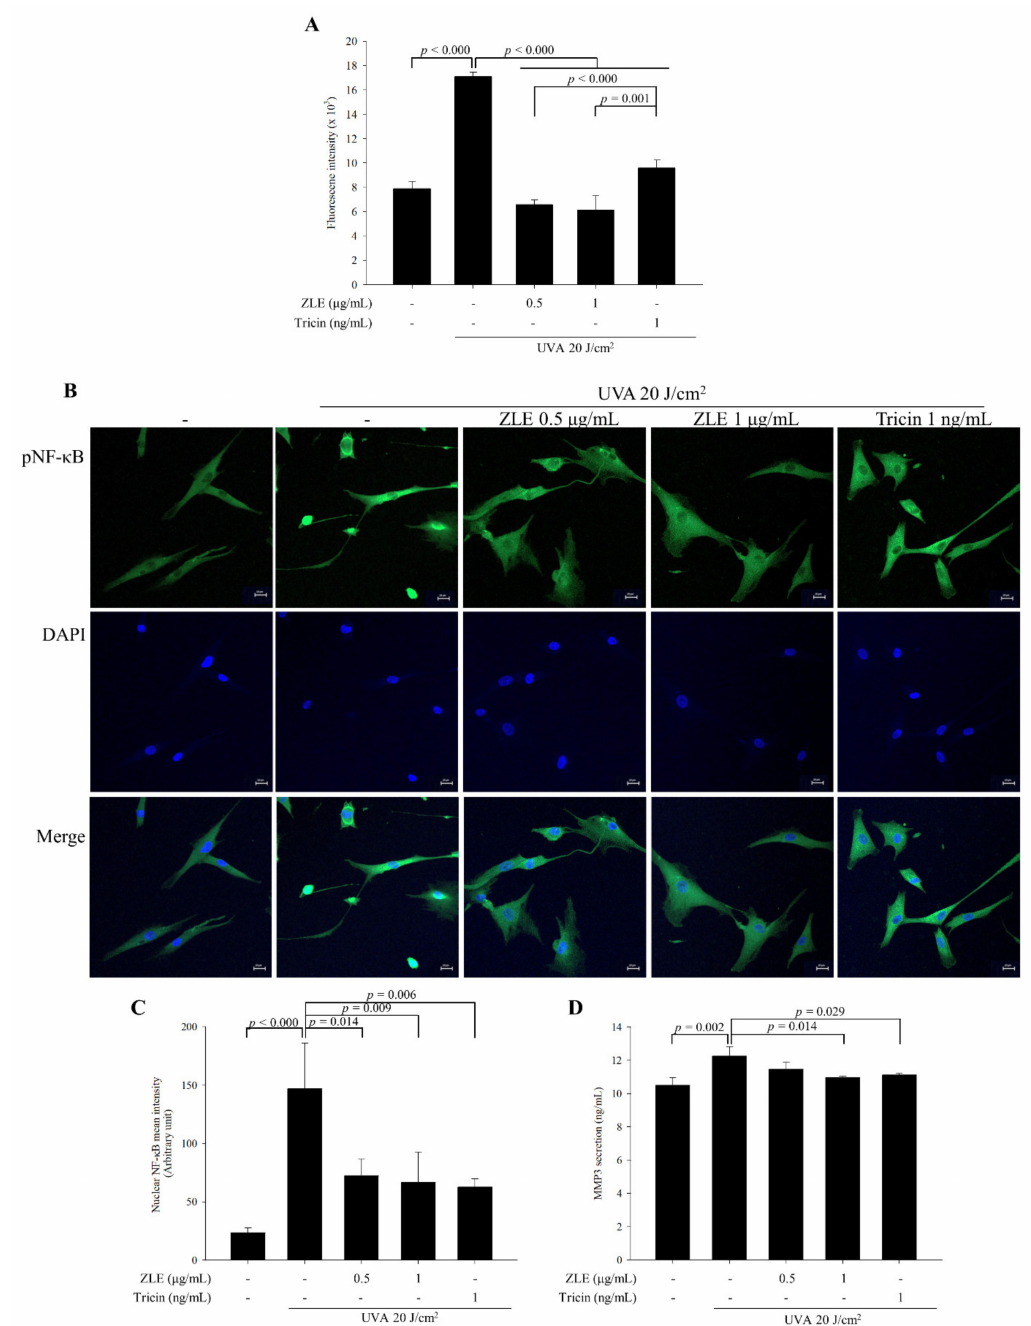
Figure 4. Enzyme-treated Z. latifolia extract (ZLE) and tricin alleviate oxidative stress and the e ff ects on thedownstreamcascadecausedbyUVAirradiationin vitro. ( A )E ff ectofZLEandtricinonUVA-induced reactive oxygen species (ROS) generation in human dermal fibroblasts (HDFs). ( B , C ) E ff ect of ZLE and tricin on UVA-induced activation of NF- κ B in HDFs. Representative images at 20 × magnification. ( D ) Secretion level of MMP3 was quantified by ELISA. The results represent three independent experiments and are expressed as the mean ± SD. The p values are determined by ANOVA and Tukey’s HSD